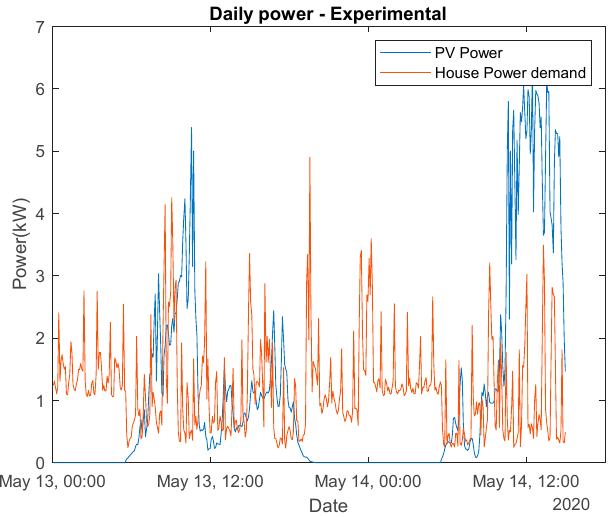
Figure 12. PV power and house power demand (cloudy day). As it can be seen, on 13 May, after 11:00, we have a very cloudy day, and the house power demand is much larger than the PV-generated power. Despite that, as the proprietary control is myopic (it does not look ahead into the future), it discharges much more of the battery than the MBPC, as can be seen in Figure 13. Please note that negative values charge the battery, while positive values denote charging.